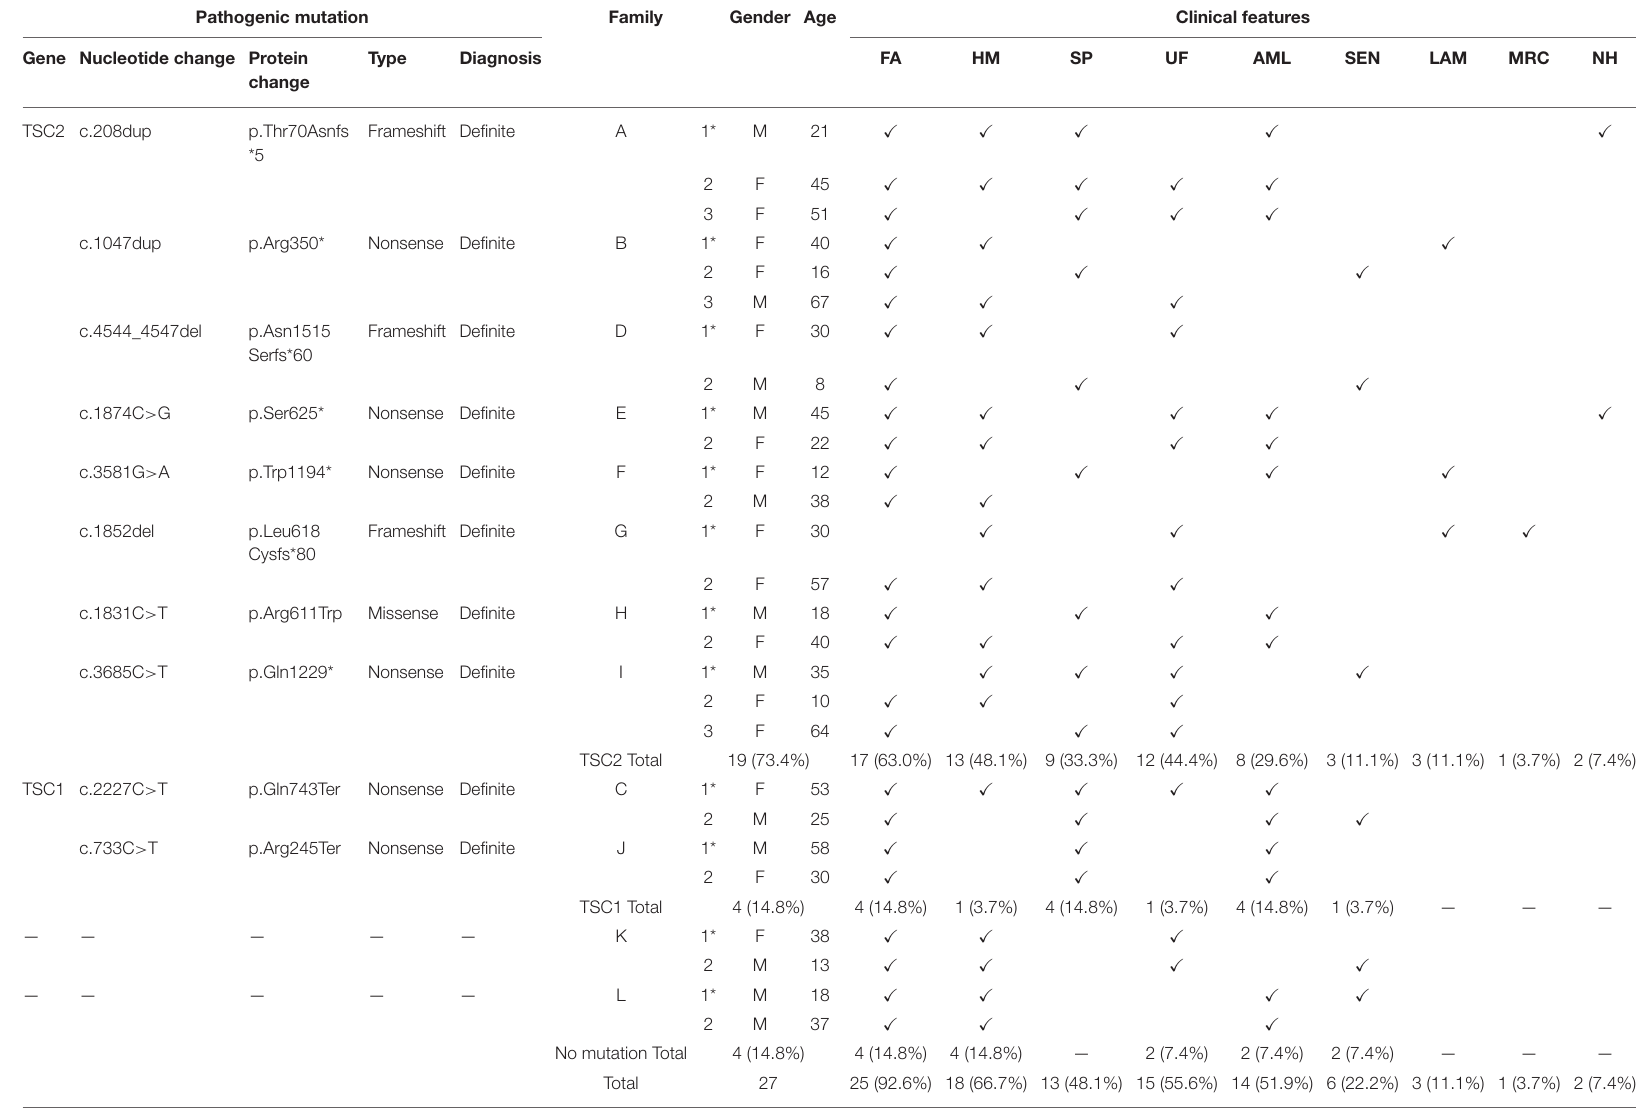
TABLE 1 | Clinical features and pathogenic mutations of TSC